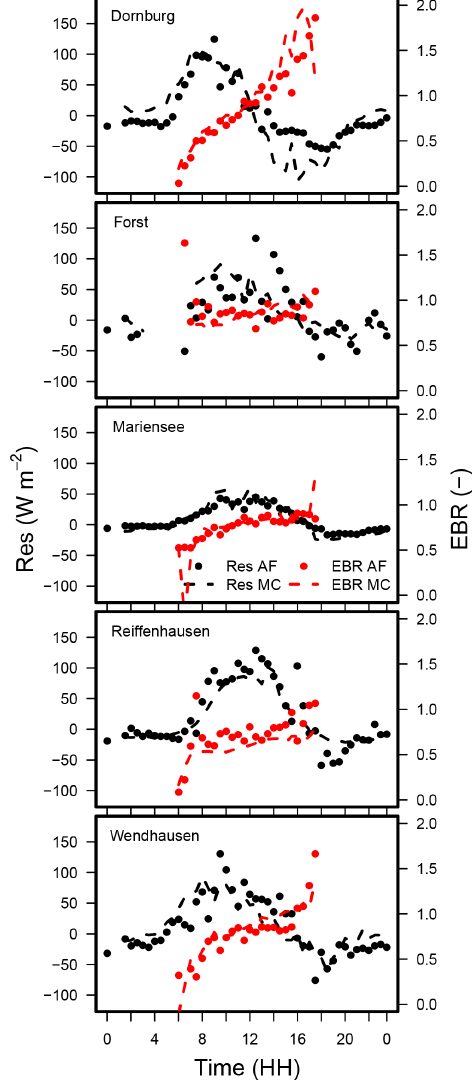
Figure C4. Median diel cycle of the energy balance ratio (EBR), and the diurnal cycle of the residual energy for the AF and the MC systems at all sites. LE was obtained by EC-LC. Data from Mariensee AF are from 23 March to 20 November 2016, and at Reiffenhausen MC the analyses are based on data collected from 7 April to 31 December 2016 because no data were available during the campaigns.